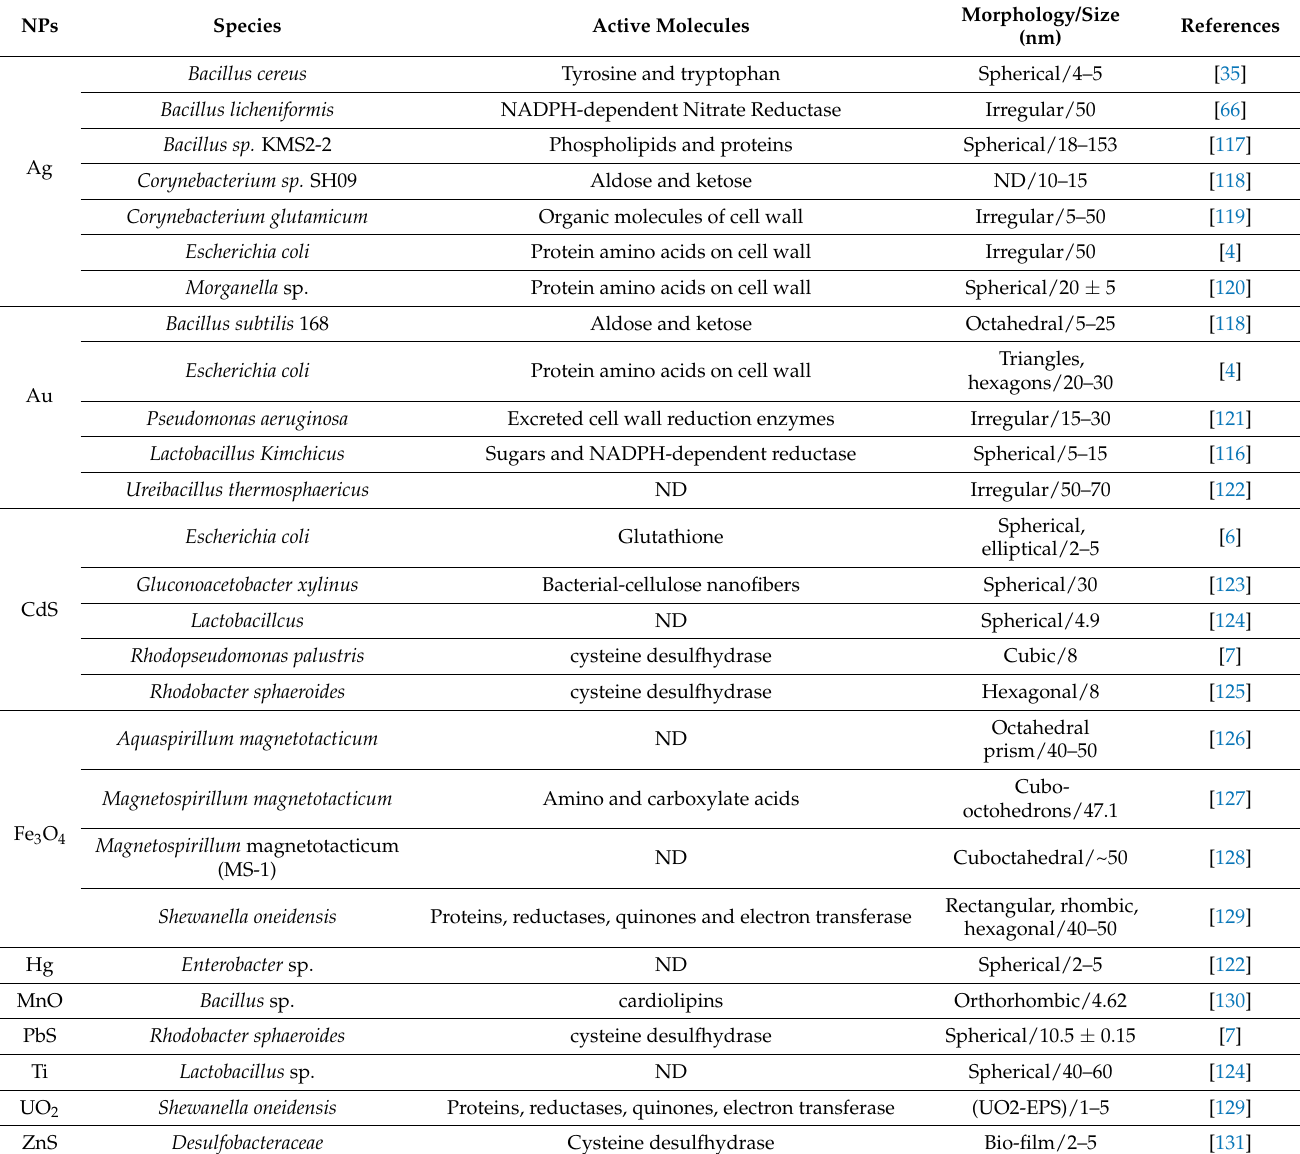
Table 1. Nanoparticles produced by